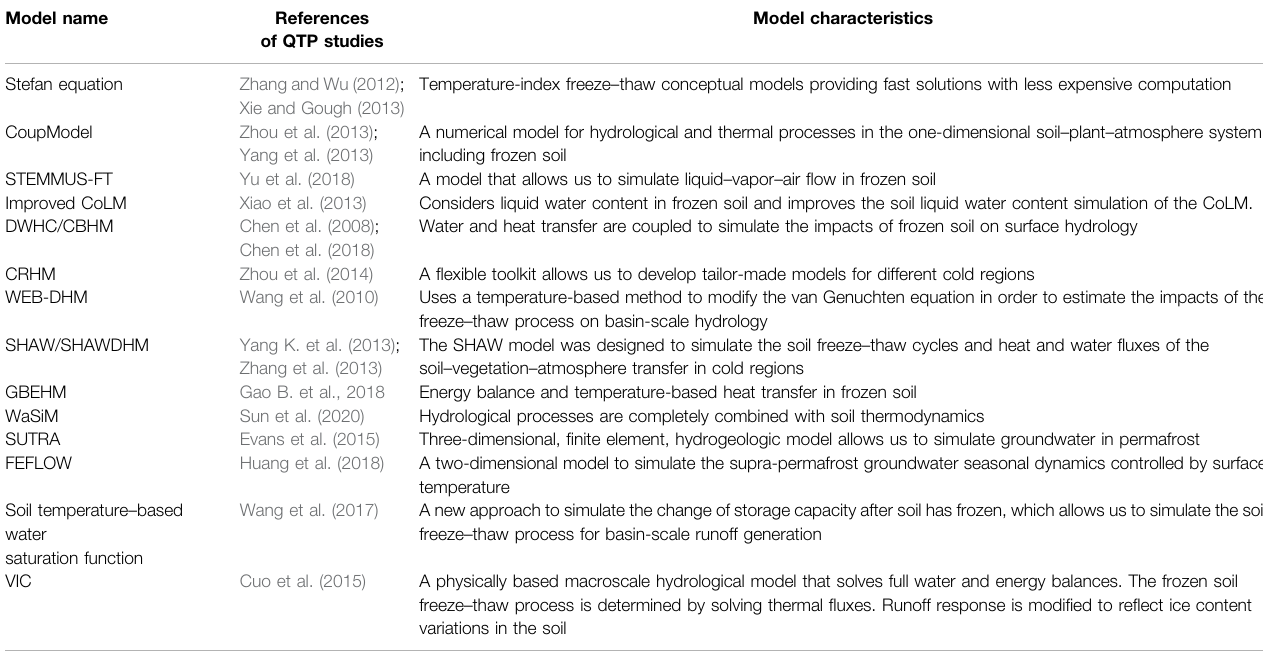
TABLE 1 | A selection of hydrological models, relevant references, model characteristics, and key fi ndings in relevant